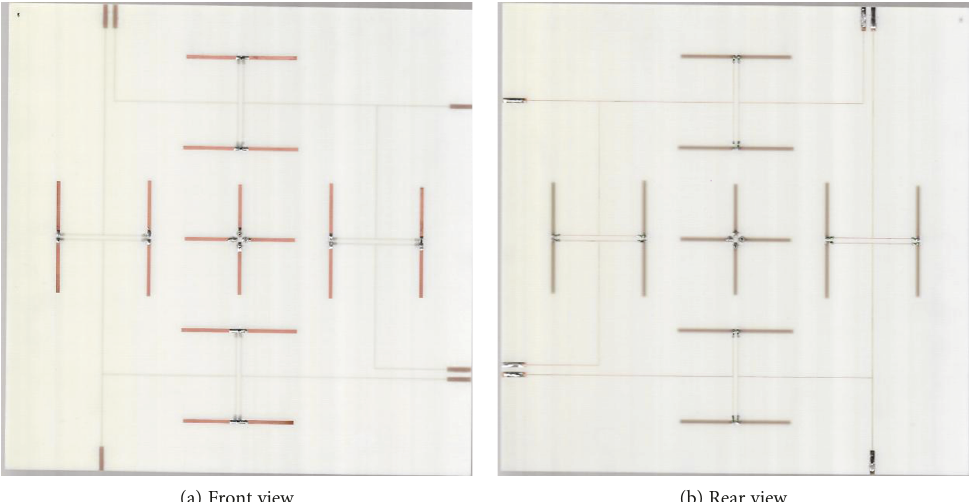
Figure 9: Photographs of the beam steering antenna system.